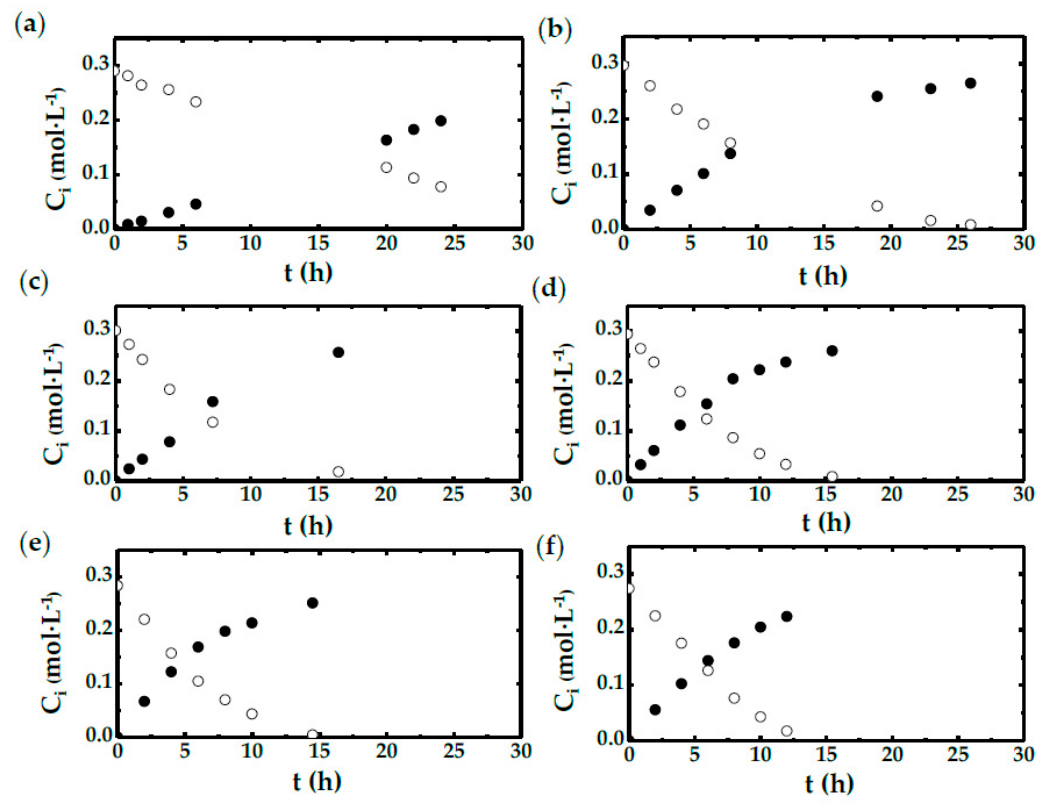
Figure 6. Experimental results. DHA ( ● ) and glycerol ( ○ ) concentrations vs. time for runs 20 to 24 (see Table 1 carried out in a stirred tank bioreactor (STBR). All runs conducted with a biomass concentration of 0.5 g·L − 1 , employing several stirring speeds according to: ( a ) 300, ( b ) 360, ( c ) 420, ( d ) 560, ( e ) 650, and ( f ) 750 rpm. Table 2. Productivity results achieved in STBR runs.